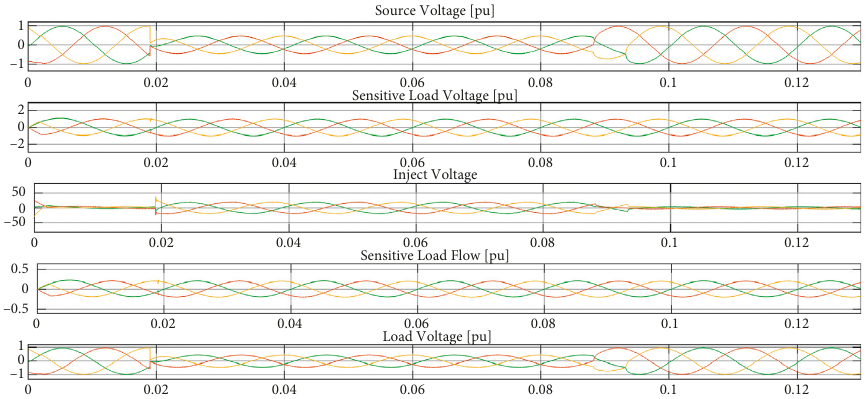
Figure 20: The result of compensating voltage sag in three-phase fault (by virtual comparison).